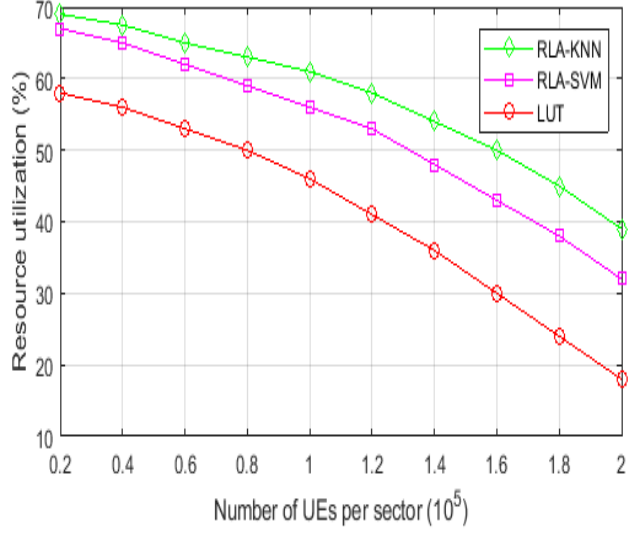
Figure 10. Resource utilization .